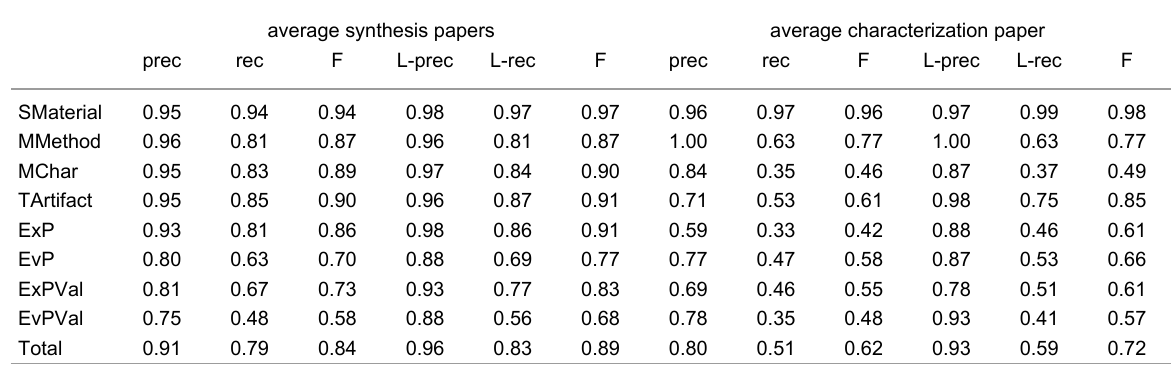
Table 5: NaDevEx average performance on synthesis and characterization papers using 10-fold cross validation. a